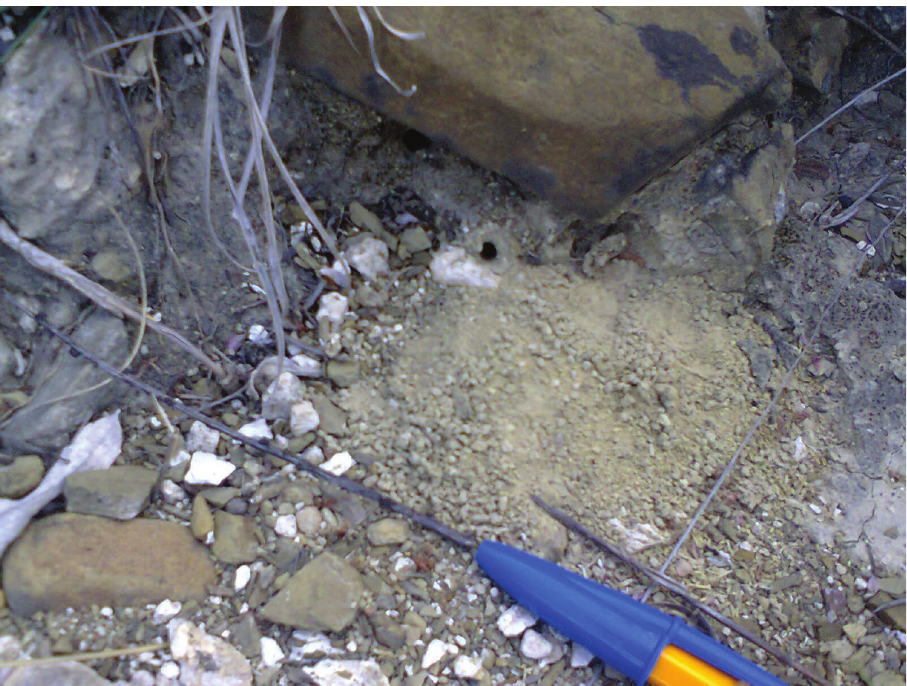
Figure 3. Nest entrance of T. pakawa . Cerro de las Letras, Saltillo, Coahuila.